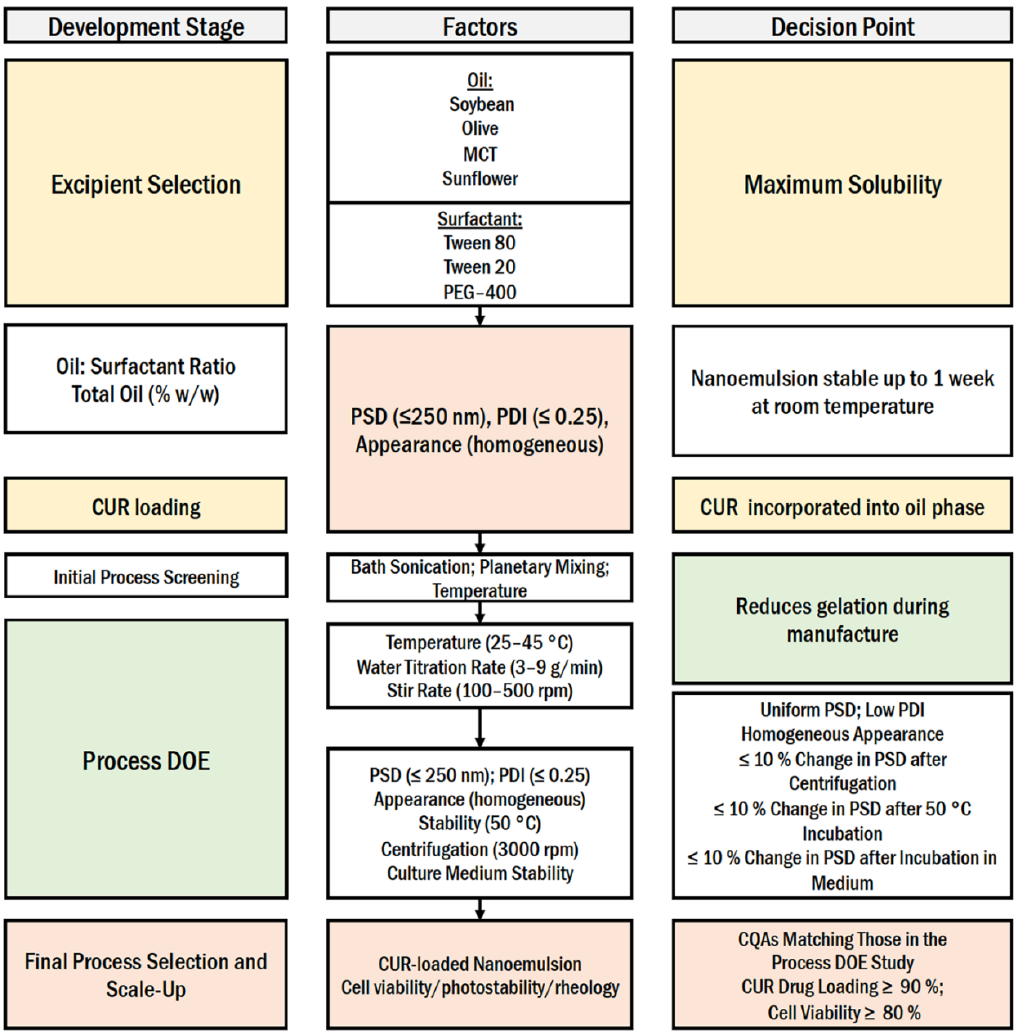
Figure 1. The quality by design (QbD) approach for the process parameters optimization and product quality control for a curcumin nanoemulsion produced by catastrophic phase inversion low-energy emulsification.